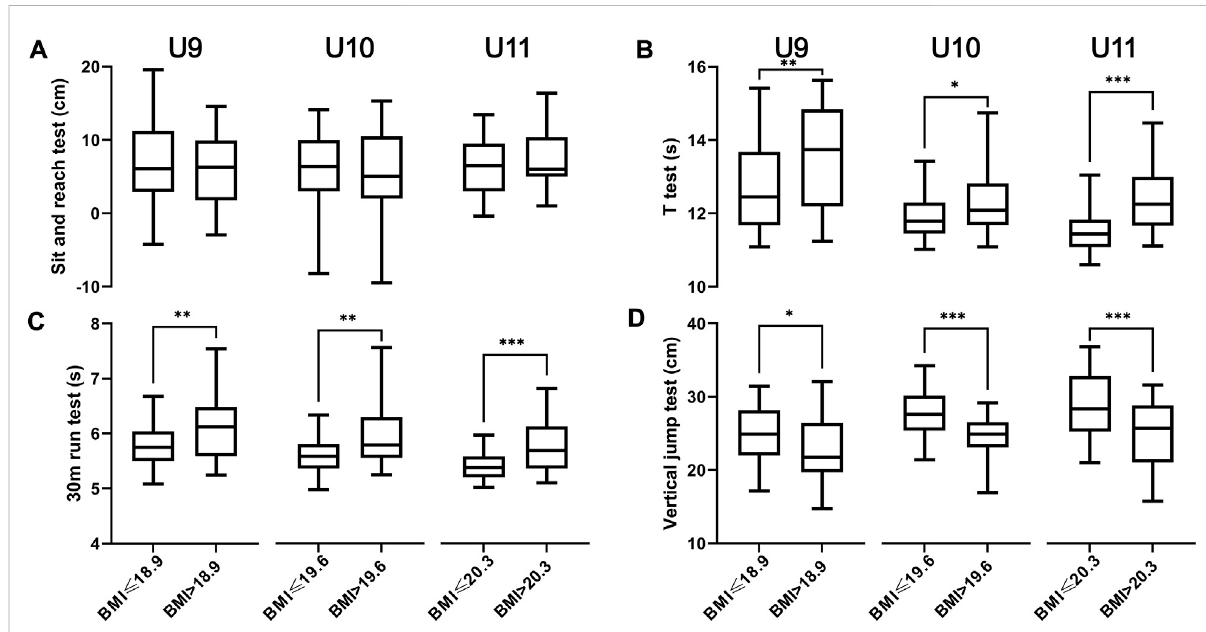
FIGURE 2 Box plots (presented as medium with 95% con fi dence interval) show the impact of body mass index on physical fi tness testing in campus football players aged 9 to 11. (A) Sit and reach test; (B) t test; (C) 30 m run test; (D) vertical jump test. * denotes p < 0.05; ** denotes p < 0.01; *** denotes p <